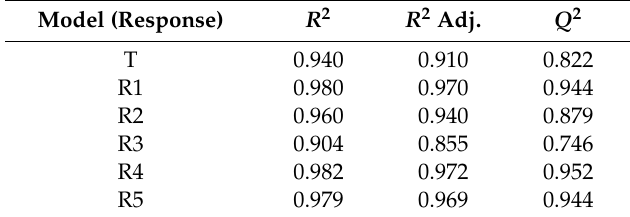
Table 2. Statistical parameters of mathematical models obtained with screening